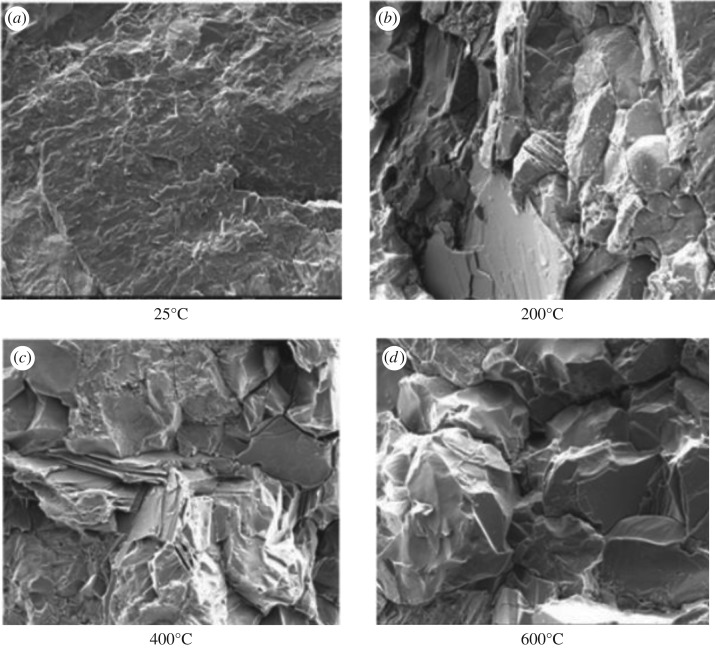
Morphology of sandstone at different temperatures [15]. (a) 25°C; (b) 200°C; (c) 400°C; (d) 600°C.